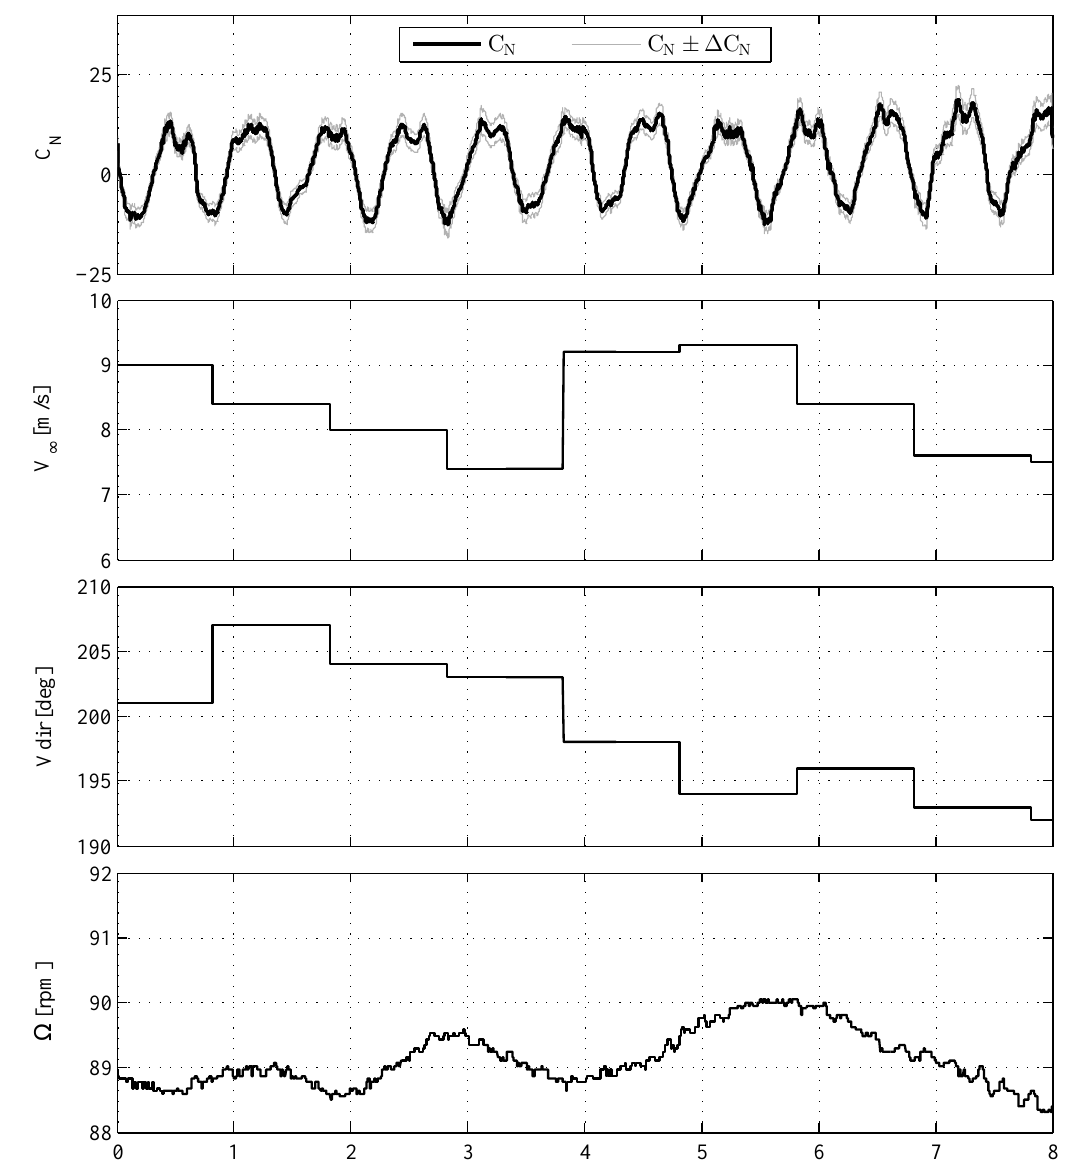
Figure 7. Normal force coefficient, wind speed, wind direction and the turbine rotational speed at unsteady wind conditions, λ = 3.6, (cid:104) Ω (cid:105) = 89 rpm. Note that V away from the